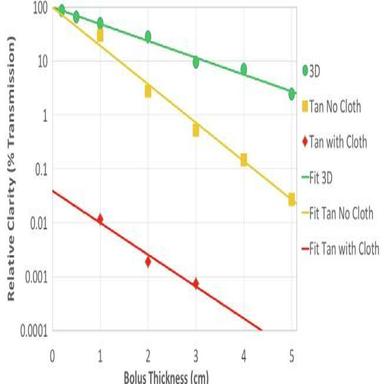
Quantitative bolus optic clarity is shown for 3D bolus (3DB), and for planar commercial bolus (PCB) with and without cloth backing. 3DB optic clarity is superior to PCB at any bolus thickness.